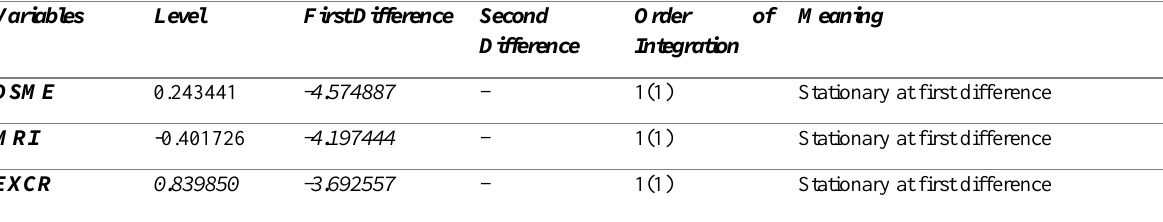
Table 7: Augmented Dickey-Fuller (ADF) Test for Unit Root/ The ADF test was done with the above